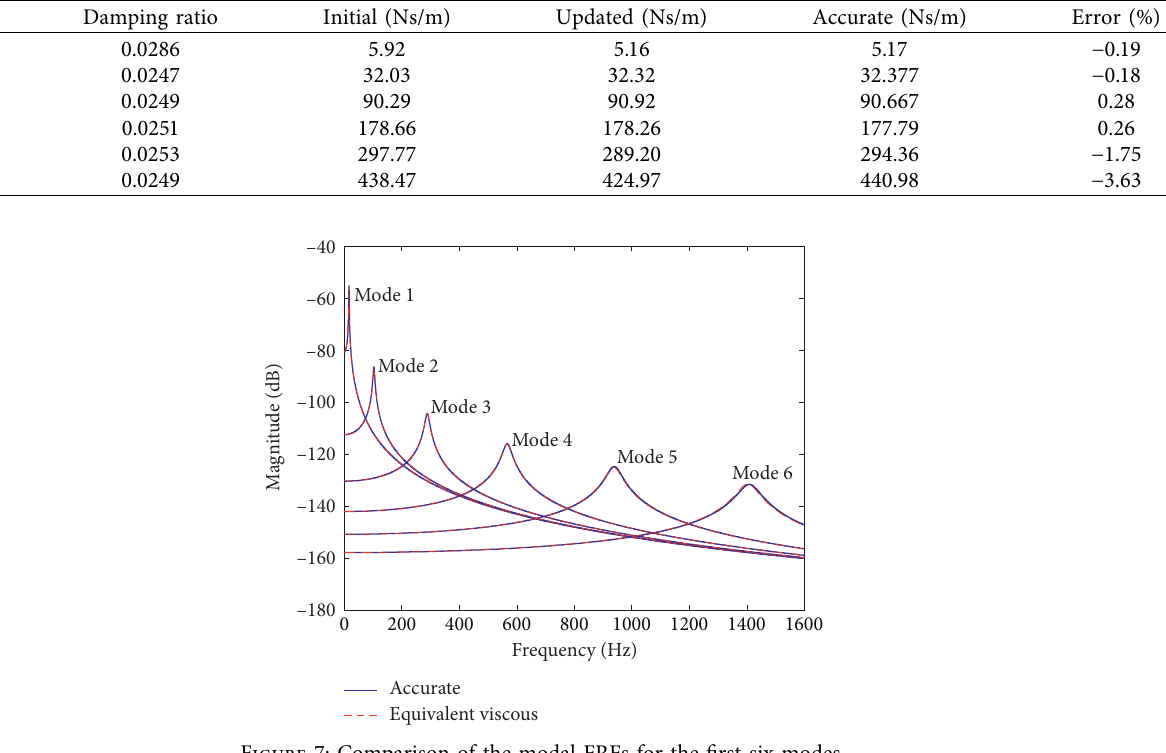
1,1 for case 2. (a) Before updating and (b) after updating.